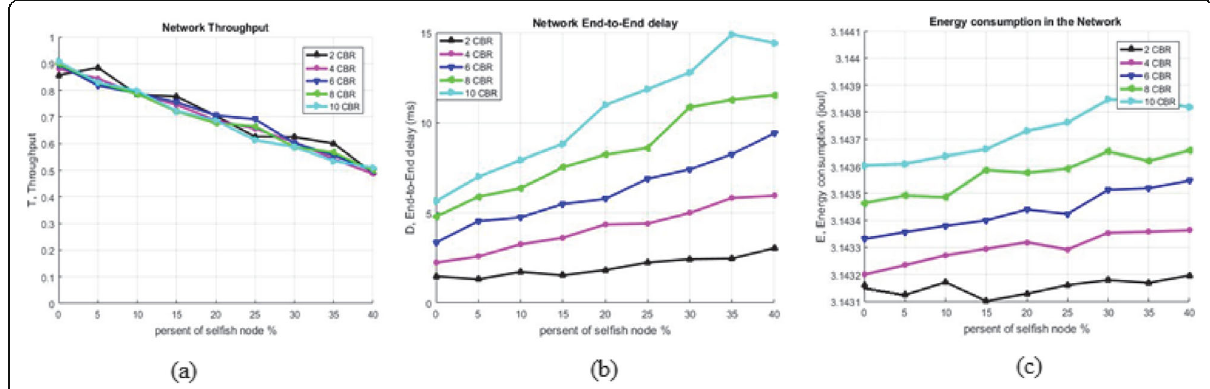
Fig. 7 Impact of the selfish node on the a throughput of the network, b end-to-end delay, and c energy